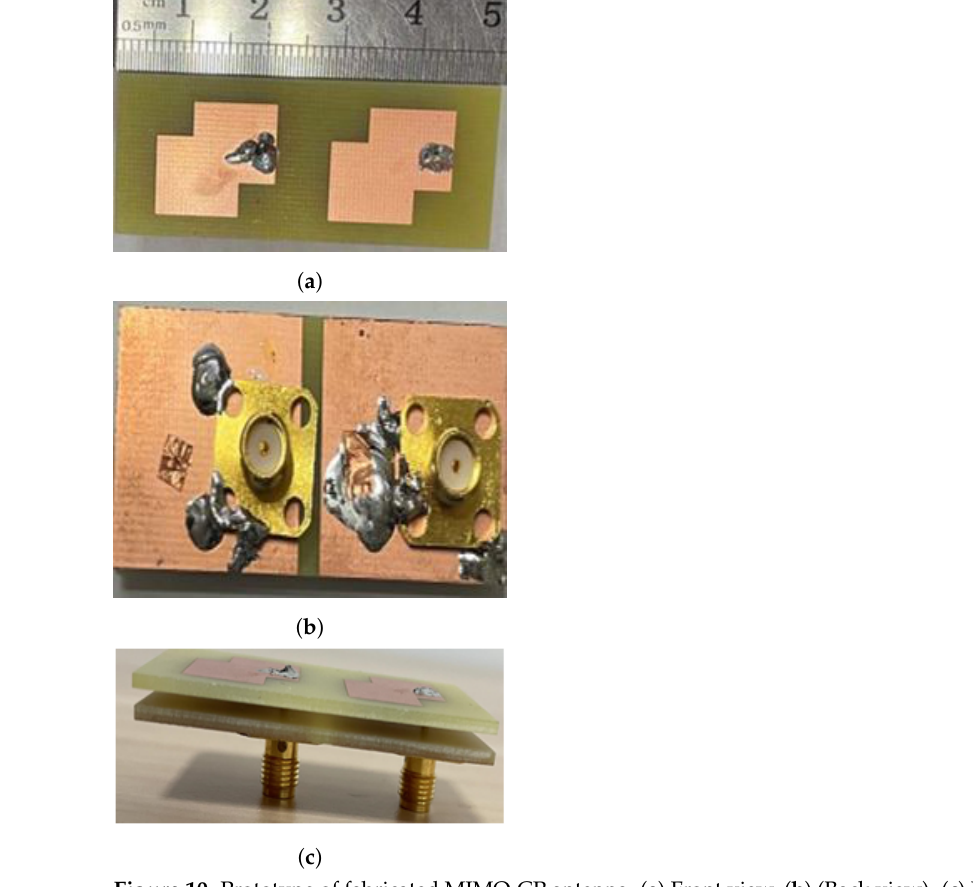
Figure 10. Prototype of fabricated MIMO-CP antenna. ( a ) Front view. ( b ) (Back view). ( c ) Bottom view.